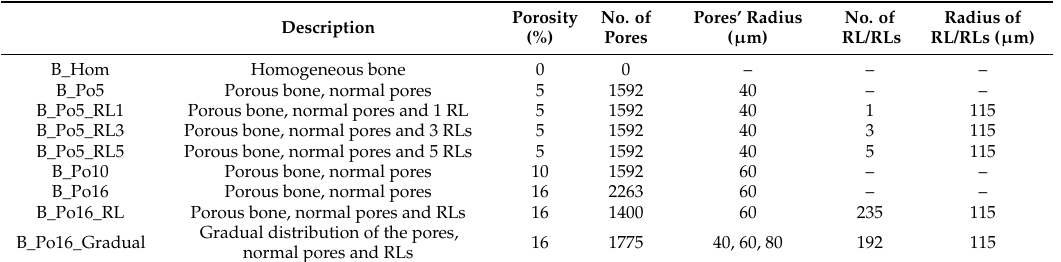
Table 2. Examined cases in the tangential direction for the second set of the simulations.